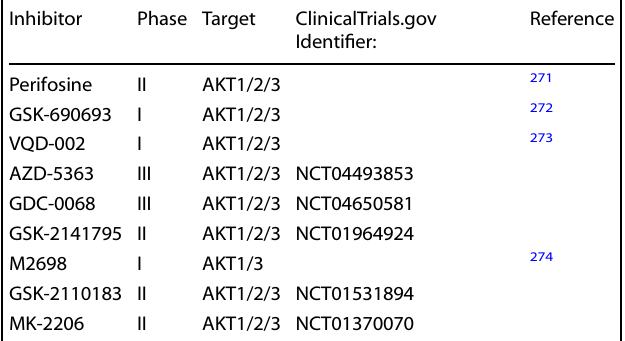
Table 3. Current inhibitors targeting Akt signaling in cancer Table 4. Therapies targeting PI3K/Akt signaling